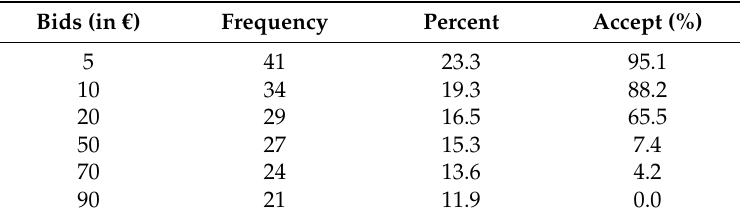
Table 3. Frequency of willingness to pay (WTP)